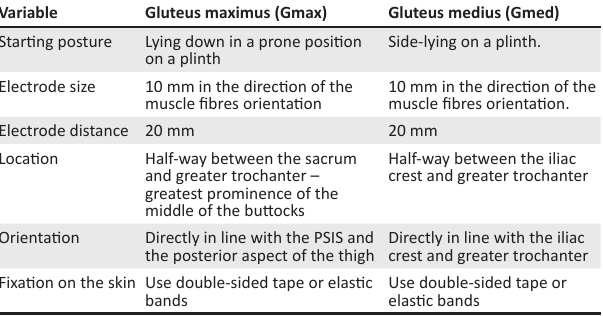
TABLE 1 : Surface EMG for non-invasive muscle assessment guidelines for surface electromyography.